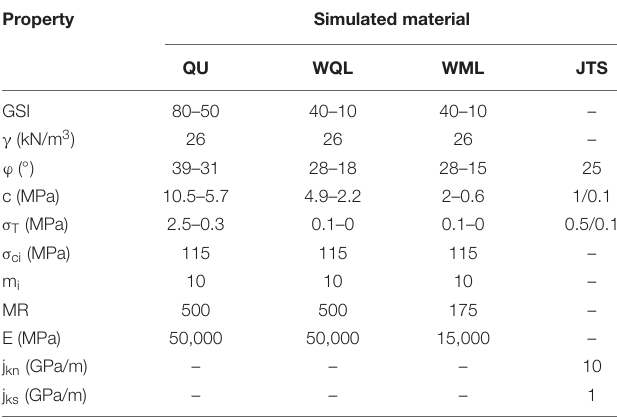
TABLE 1 | Material and discontinuity properties used for the Slide and Phase2 models. Property